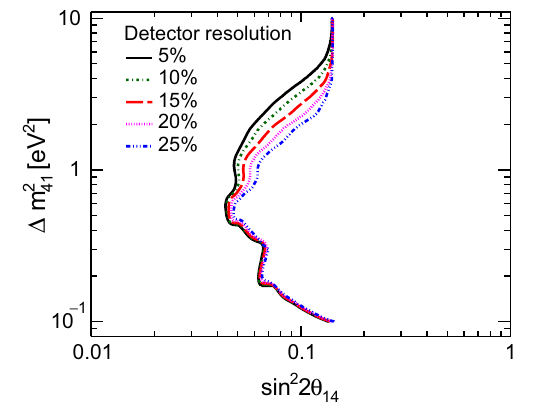
Fig. 5 The 90% C.L. exclusion limits in the Δ m 2 − sin 2 2 θ 14 plane, 41 where sin 2 2 θ 14 = 4 U 2 ( 1 − U ) 2 , expected from 1ton-yr of the data e 4 e 4 at various detector efficiencies